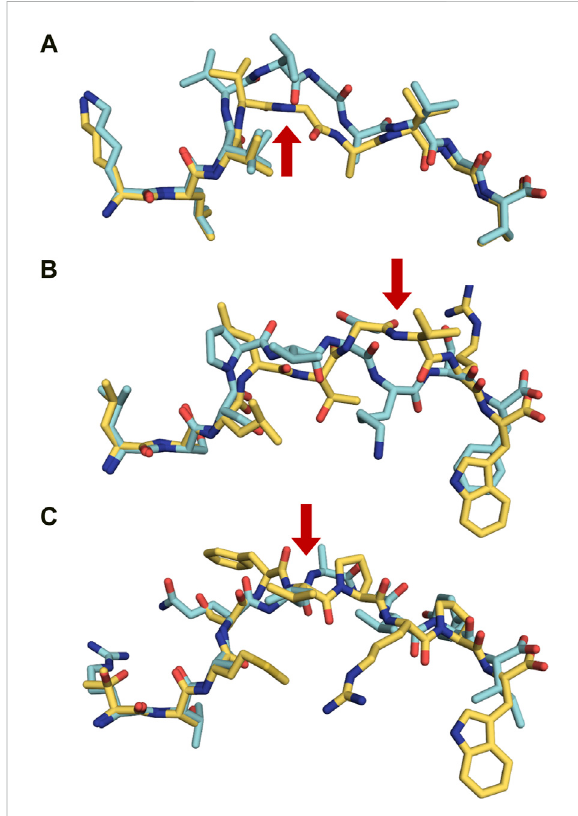
FIGURE 6 Proteasomally spliced peptides bind in a canonical mode to MHC molecules (A) Comparison of the conformations of the original KRAS 5-14 peptide (6O53. pdb, cyan) and its cis-spliced variantKRAS 5-6/8 – 14 (6O4Y.pdb,yellow) bothincomplexwith HLA-A2*01 demonstrates that the splicing results in the formation of a neoepitope through the removal of a central conformational bulge following splicing (Mishto et al., 2019). The red arrow shows the junction between spliced fragments. (B) Although sequentially unrelated, a comparison of the linear nonameric self-peptide 94- LSSPVTKSF-102 derived from immunoglobulin kappa (2RFX.pdb, cyan) (Chessman et al., 2008) and the nonameric cis-peptide LALLTGVRW (6D2T.pdb, yellow) reveals that i) they make use of similar anchor residues (p2A/p2S and pF9/pW9) in order to bind to HLA-B*57:01 (Faridi et al., 2018; Mishto et al., 2019), and ii) that the junction between spliced fragments is protruding towards the solvent, readily available for interactions with TCRs (red arrow) (C) . A similar comparison is presented here with two unrelated decameric peptides. The junction between spliced fragments in thetrans-splicedepitopeTSMSFVPRPW(6D29.pdb,yellow) (Faridi et al., 2018) is also available for interactions with TCRs. The HLA- B*57:01-restricted decameric peptide from small nuclear protein SmD3 54-RVAQLEQVYI-63 (3VRI.pdb) is presented as a reference for a conventional epitope (Illing etal., 2018). The red arrow shows the junction between spliced